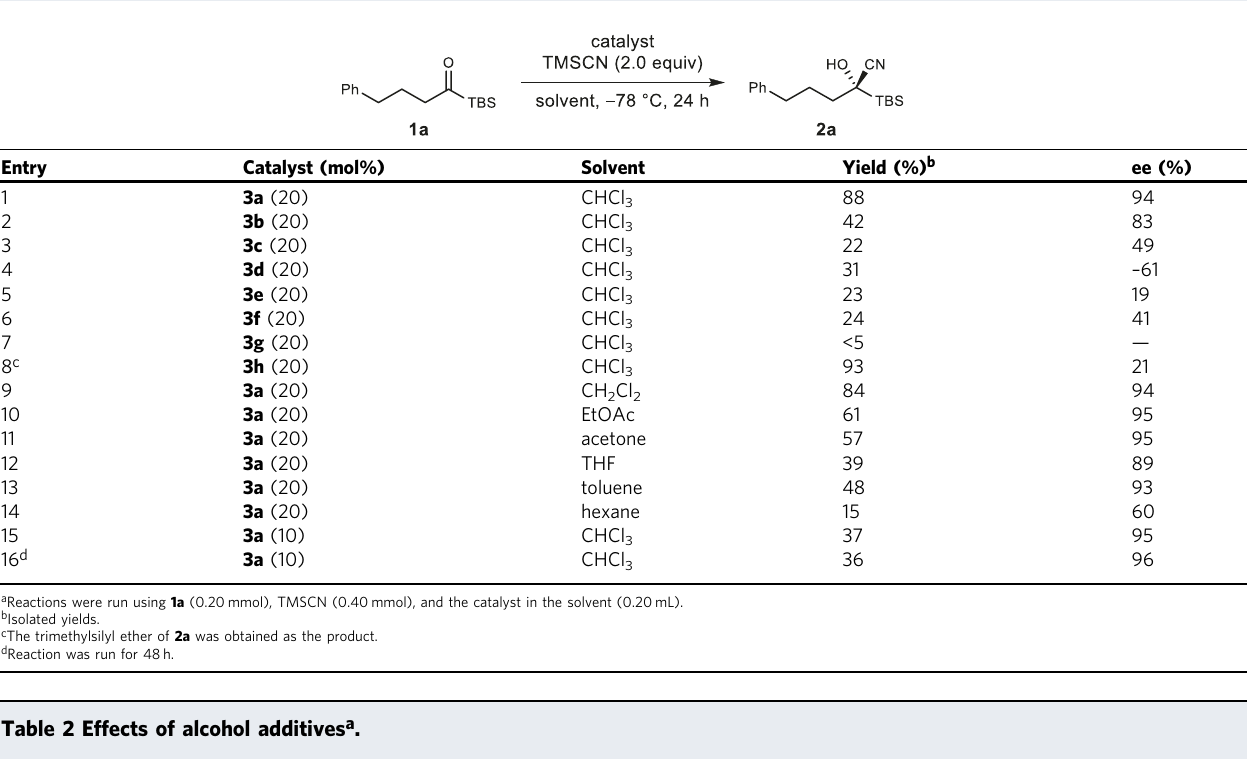
Table 1 Optimization of reaction conditions a .